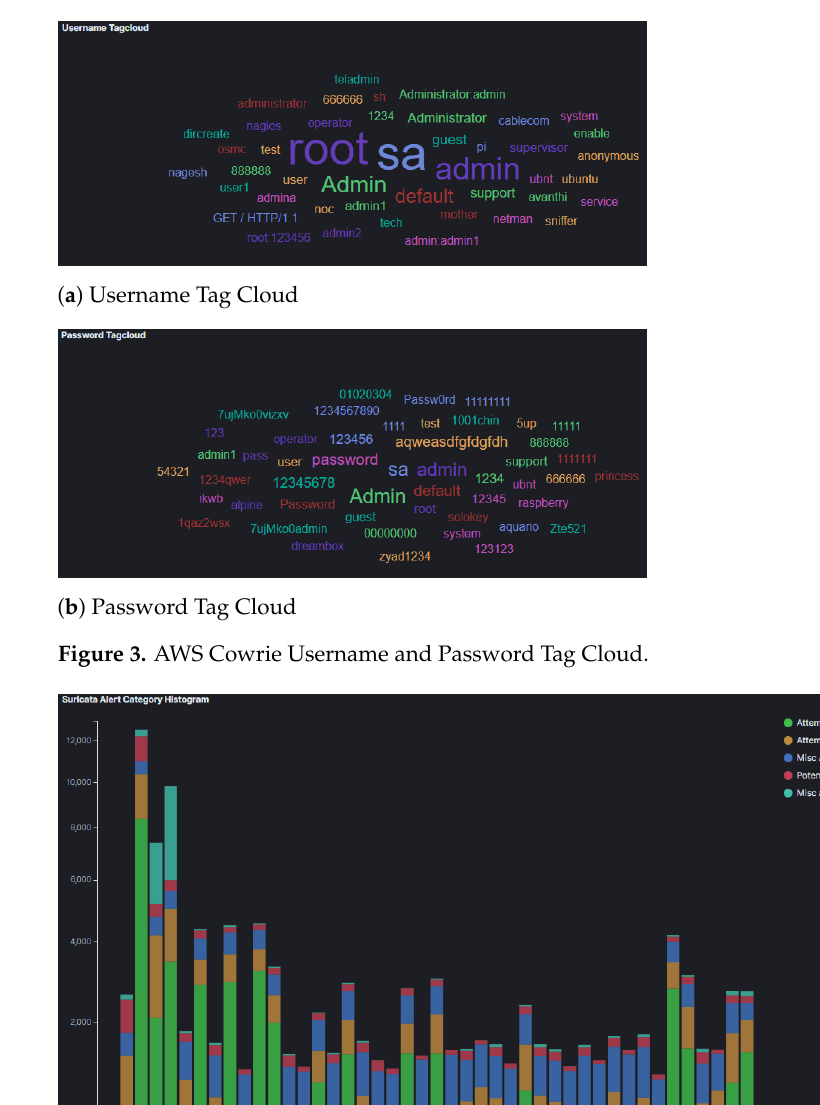
Figure 5. GCP Honeypot Attacks—Top